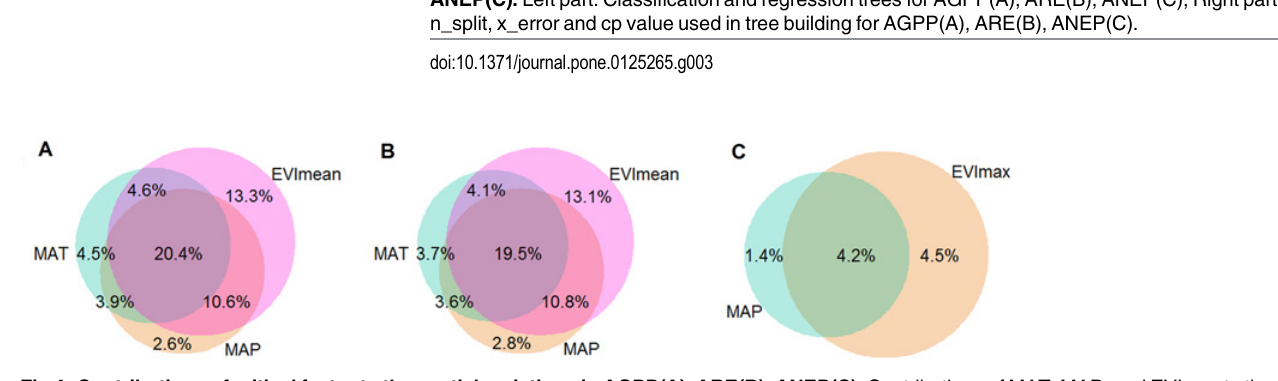
PLOS ONE | DOI:10.1371/journal.pone.0125265 April 30,